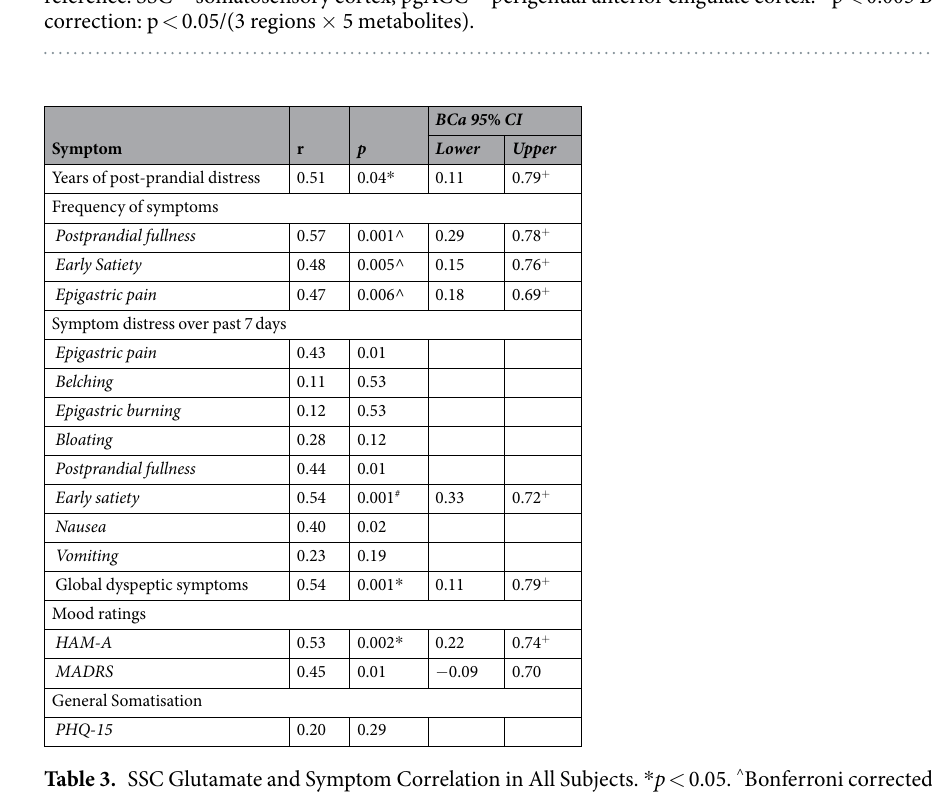
Table 3. SSC Glutamate and Symptom Correlation in All Subjects. * p < 0.05. ^ Bonferroni corrected p < 0.017 ( = 0.05/3). # Bonferroni corrected p < 0.006 ( = 0.05/8). + BCa 95% CI not including